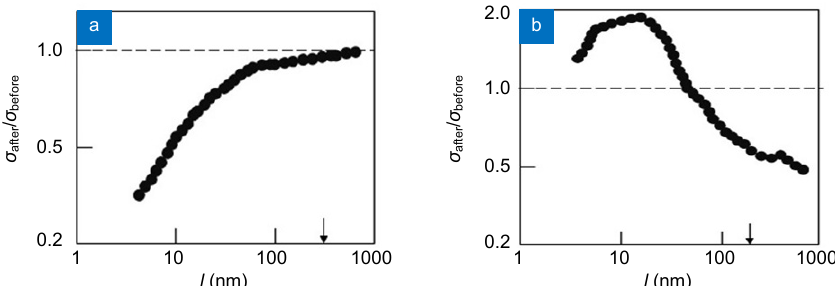
Fig. 3 | The ratio of the standard deviation of the roughness of the PMMA surface before and after etching. ( a ) and ( b ) are the results acquired by illuminating the surface with light having wavelengths of 325 nm and 213 nm, respectively. The downward arrows represent the val- ues of l that are equal to the wavelengths